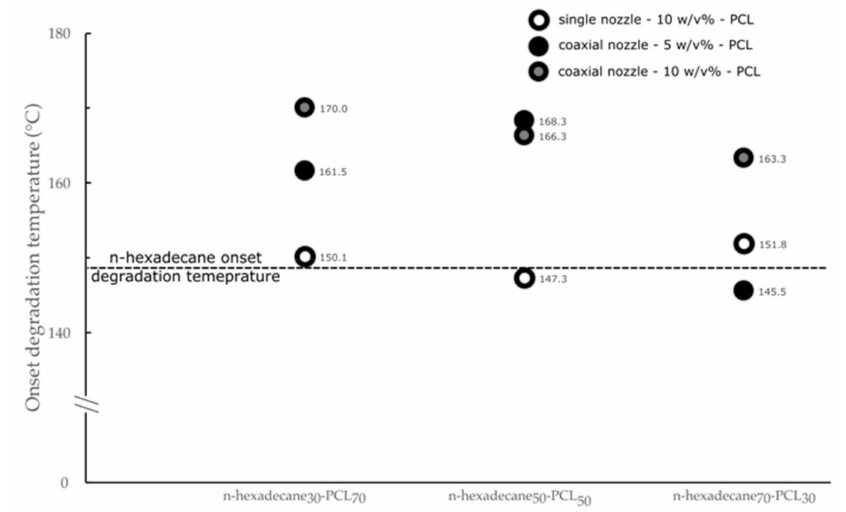
Figure 6. Influence of the electrospraying process on the thermal degradation of the